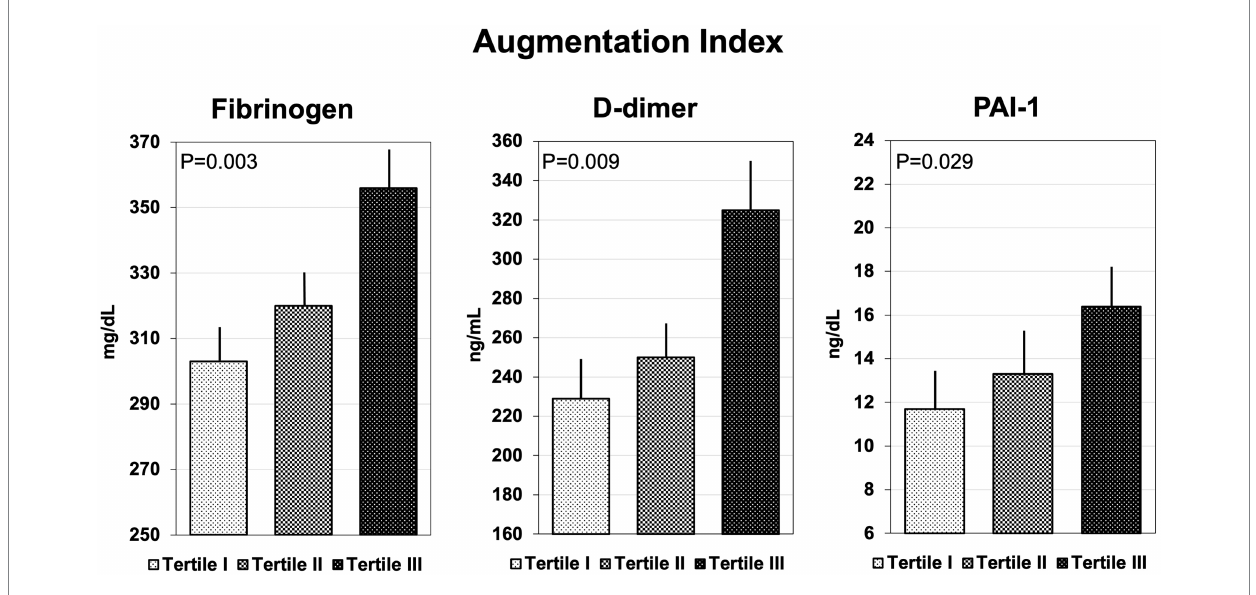
FIGURE 1 Bar graph showing the plasma concentrations of fibrinogen, D-dimer, and plasminogen-activator inhibitor-1 (PAI-1), across tertiles of Augmentation